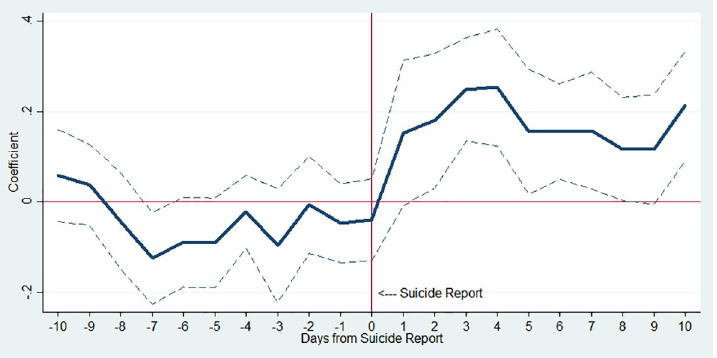
The dotted lines indicate 95% confidence